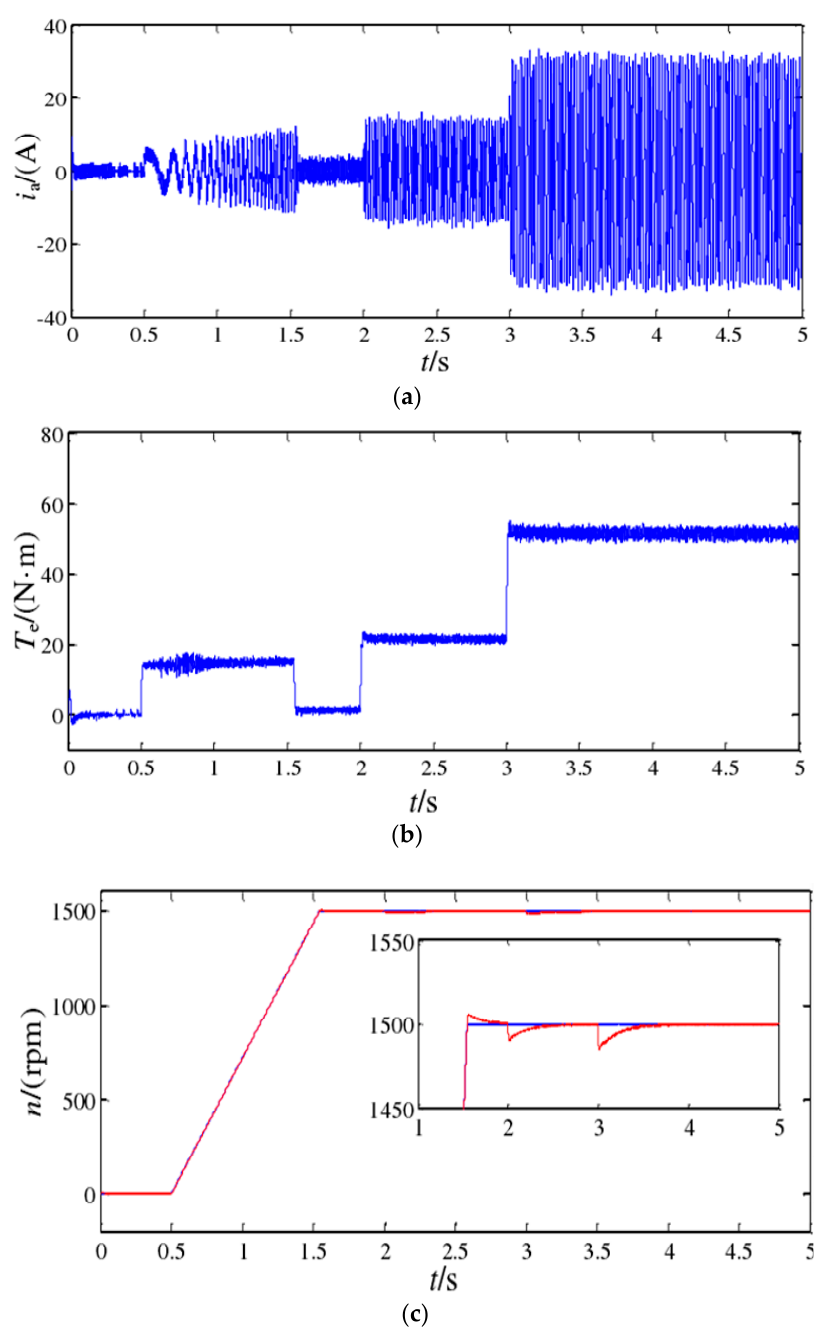
Figure 13. Simulation waveform of EESM by Forward Euler method: ( a ) a phase stator current waveform; ( b ) motor torque waveform; ( c ) motor speed waveform